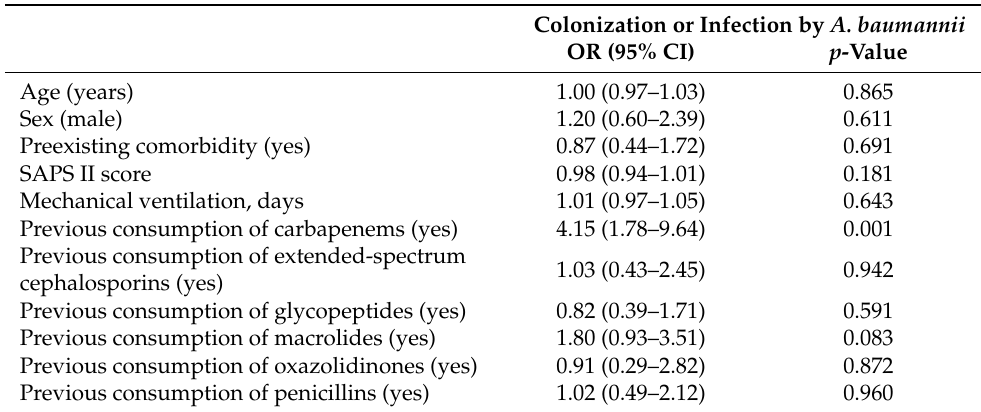
Table 3. Multivariable logistic regression model for colonization or infection by A. baumannii among the SARS-CoV-2 patients admitted to the main intensive care unit of the Umberto I teaching hospital of Rome between 1 March 2020 and 28 February